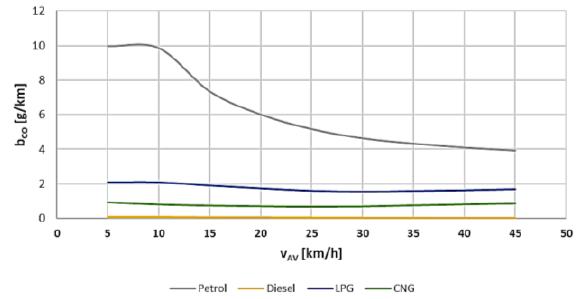
Fig. 37. CO emission from PCs for fuel type depending on average